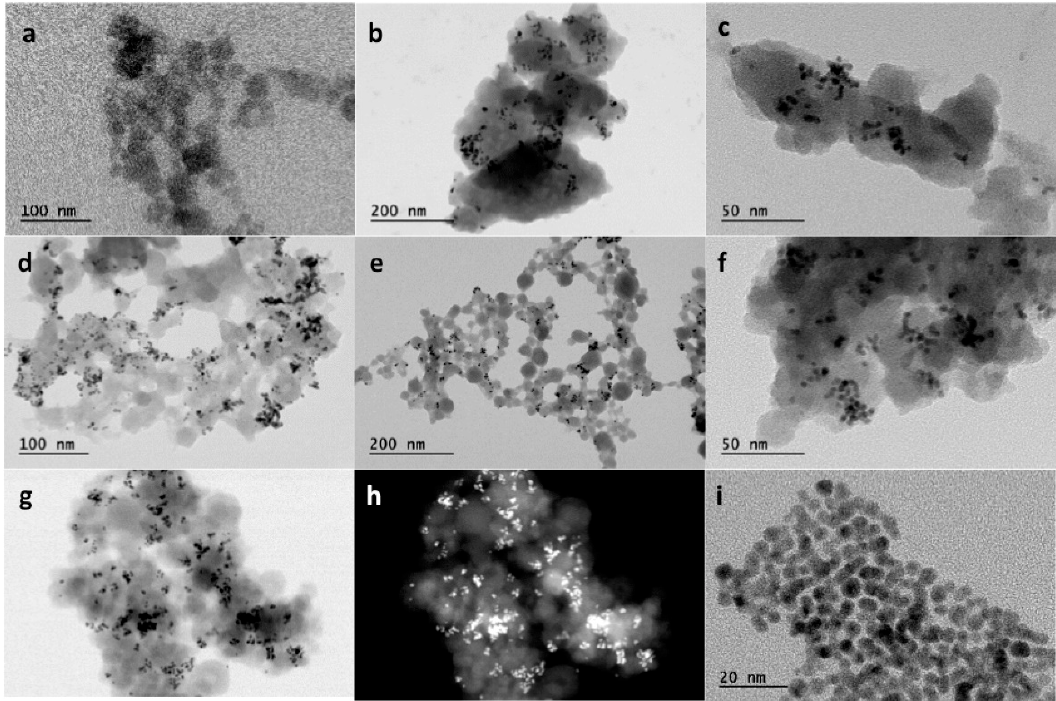
Figure 2. Transmission electron microscopy (TEM) images of ( a ) bare SiTi; ( b ) Au@SiTi; ( c ) Pd@SiTi; ( d ) Au 4 Pd 1 @SiTi; ( e ) Au 1 Pd 1 @SiTi; ( f ) Au 1 Pd 4 @SiTi; ( g ) Au 1 Pd 1 @SiTi; ( h ) Au 1 Pd 1 @SiTi in dark field measurement and ( i ) preformed Au 1 Pd 1 nanoparticles stabilized by sodium citrate and used for the embedded catalysts synthesis.